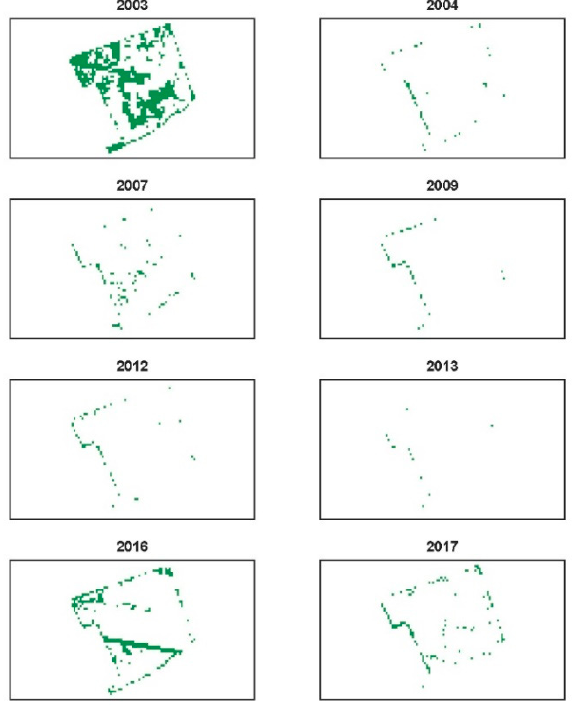
Remote Sens. 2021 , 13 , x FOR PEER REVIEW 13 of 19 Figure 5. The pixels where the conditions were met to include sowing date (+SD) in the statistical phenological detection (SPD) and had start of season (SOS) date corrected for the testing field M.